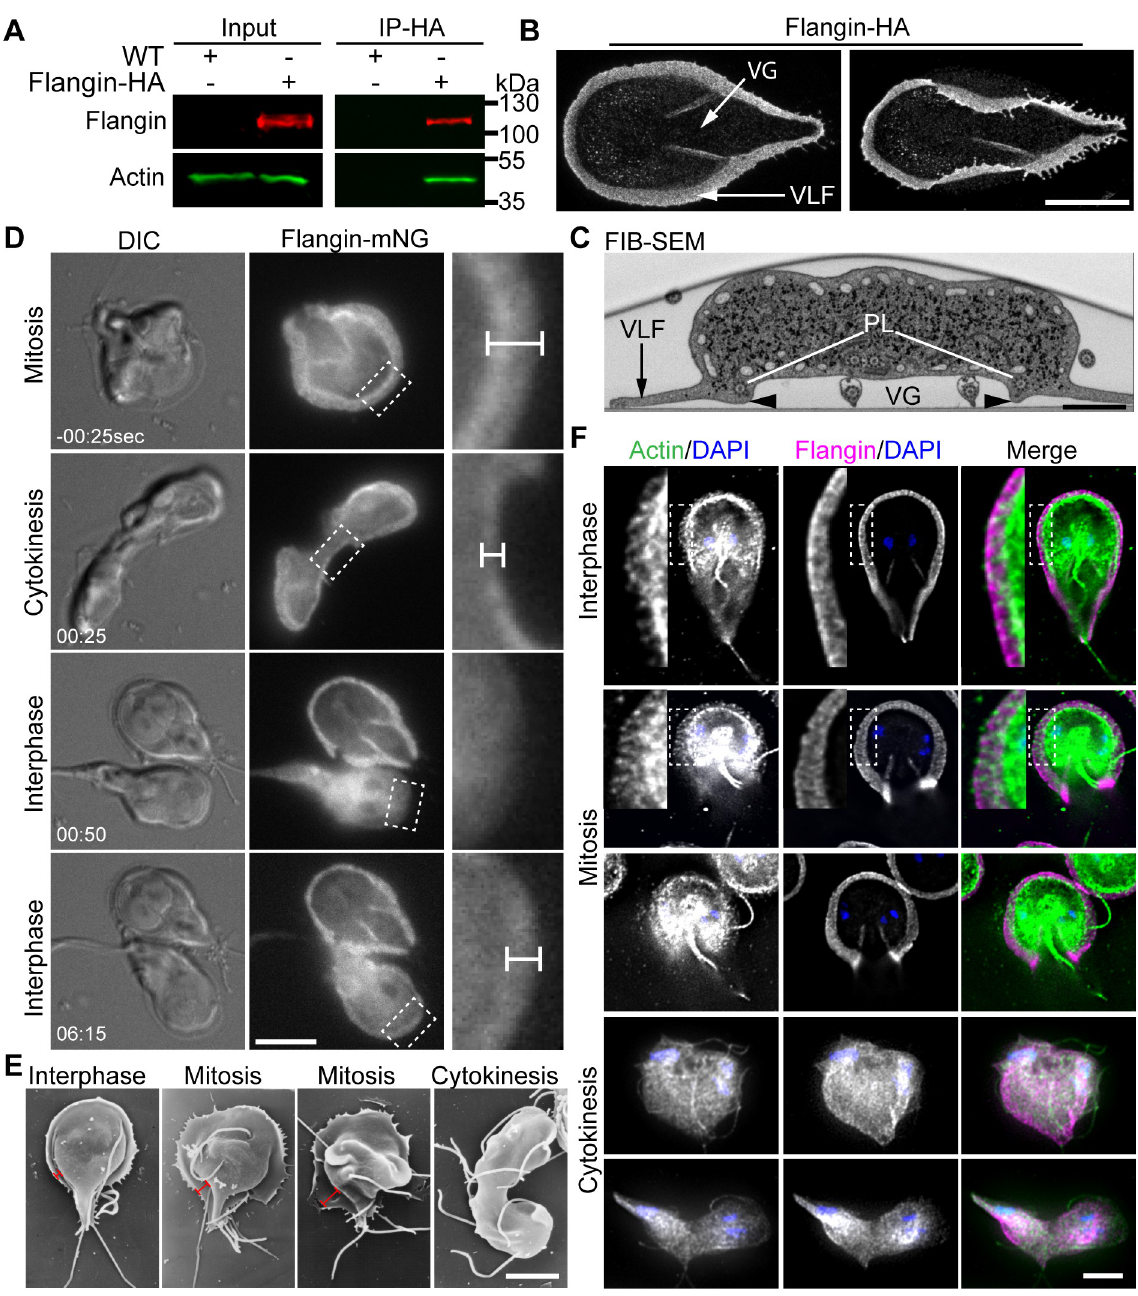
Fig 1. Giardia possesses a lamellipodium-like structure that contains Gl Actin and Flangin. (A) Immunoprecipitation of Flangin-HA from cell extracts, followed by anti- Gl Actin Western blotting demonstrates Flangin associates with Gl Actin. (B) Maximum projections of expanded trophozoites imaged with confocal fluorescence microscopy. Flangin-HA marks the ventrolateral flange (VLF) and membrane protrusions associated with the cytoplasmic portions of the posterolateral flagella axonemes that bound the ventral grove (VG). The left image shows that the flange can completely encircle the base of the cell and the image on the right shows that the flange is thin and flexible. (C) Transverse section of wild-type Giardia (posterior to the ventral flagella exit point) as viewed with Focused Ion Beam-Scanning Electron Microscopy (FIB-SEM). Arrowhead marks the membrane protrusion associated with Flangin and the cytoplasmic axonemes of the posterolateral (PL) axonemes that bound the ventral groove. (D) Live cell imaging of Flangin-mNG during cytokinesis. Compared with interphase cells the flange is wider in mitosis and was resorbed during cytokinesis. Upon cytokinesis, the flange disassembled and Flangin-mNG translocated to the cytoplasm. Daughter cells lack a flange, but assembly was initiated almost immediately after division. Flangin-mNG was recruited back to the flange as it reformed (see S1 Movie). Magnified views of the boxed area show Flangin is at the leading edge of the flange. Dimension bars in C and D point out flange width. (E) Scanning electron microscopy shows an expanded flange in mitosis and the lack of a flange during